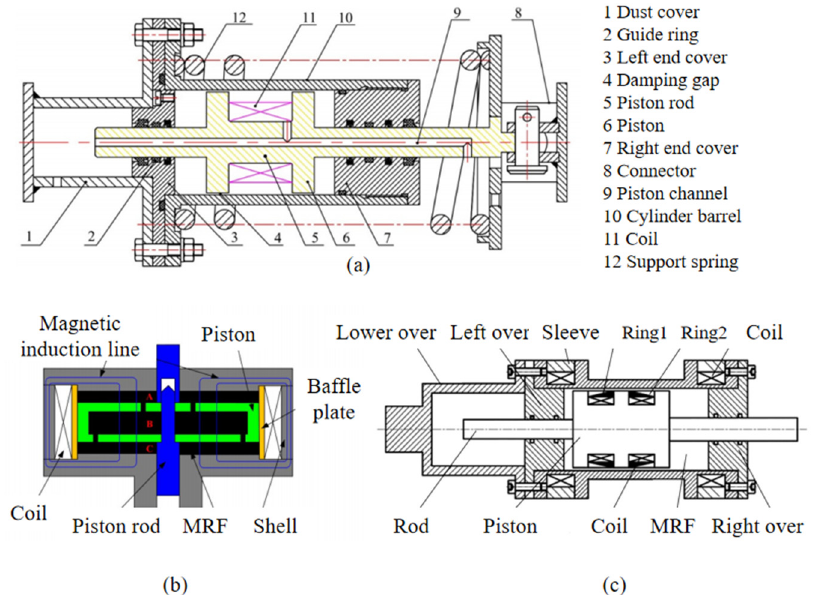
Figure 14. MRDs with hybrid working mode type: ( a ) Shear-flow dual-mode MRD [85]. ( b ) Flow- extrusion dual-mode MRD [86]. ( c ) Shear-squeeze dual-mode MRD [87].